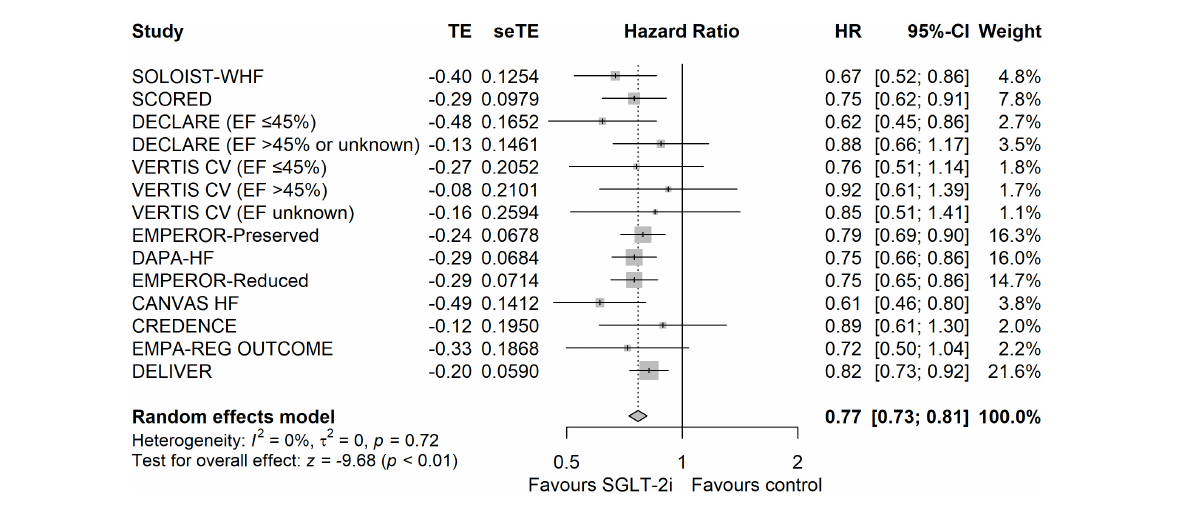
according to the EF value. The results showed that the reduction in composite outcome was consistent for different EF value groups (Pinteraction = 0.77) ( Supplementary Figure 7 ). The results of the subgroup analysis according to the population characteristics are shown in Supplementary Figures 11–21 .